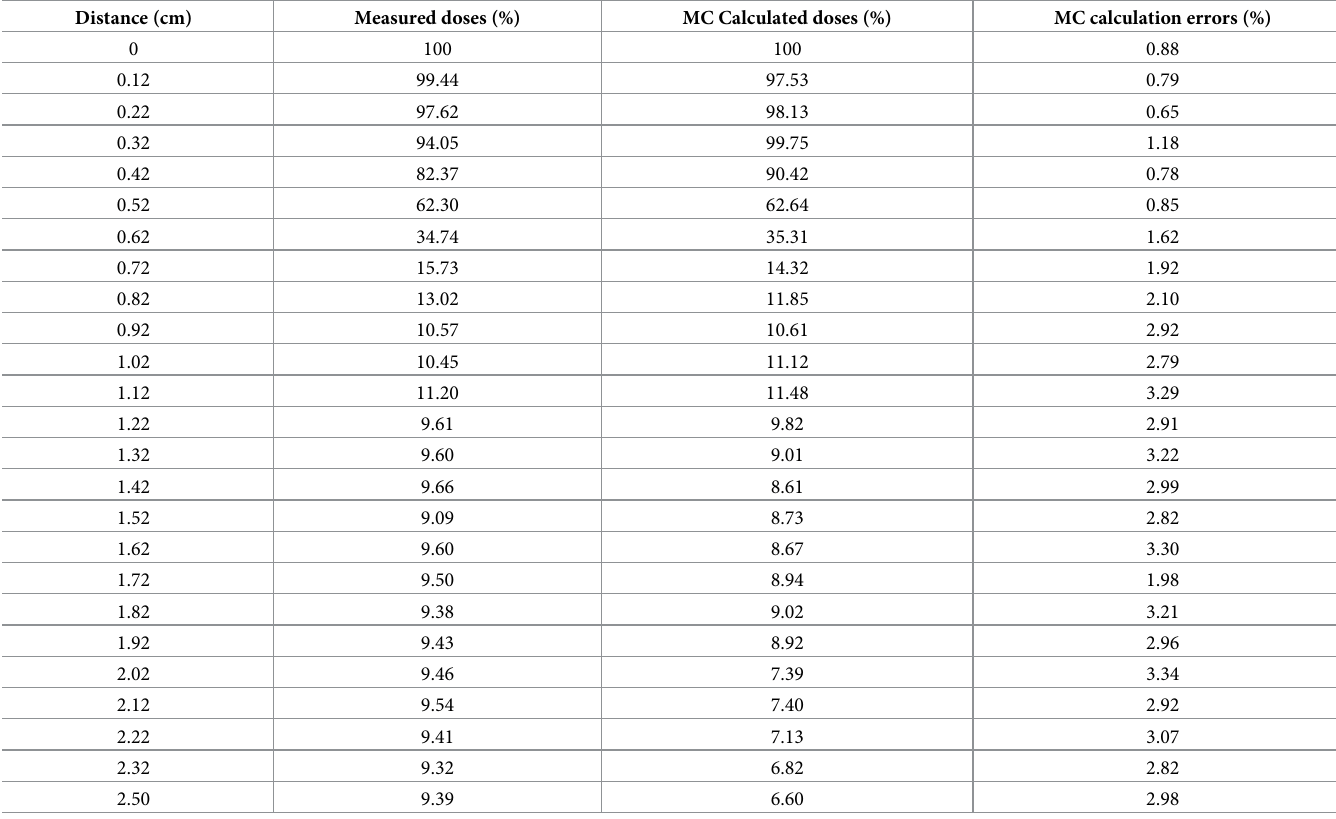
Table 1. Measured and calculated doses and MC dose calculation errors. Distance (cm)